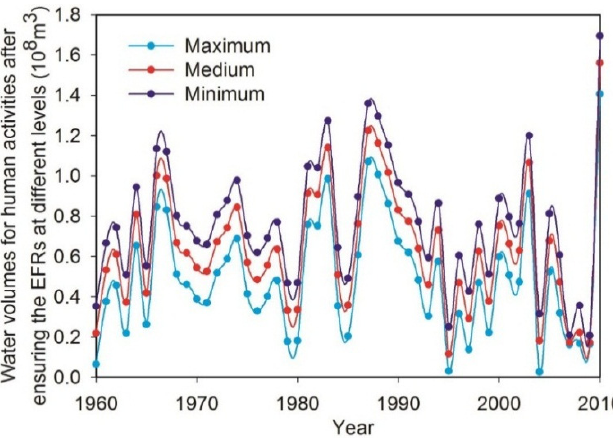
Figure 8. Water volumes needed to support human activities after ensuring the EFRs at different levels in Qira